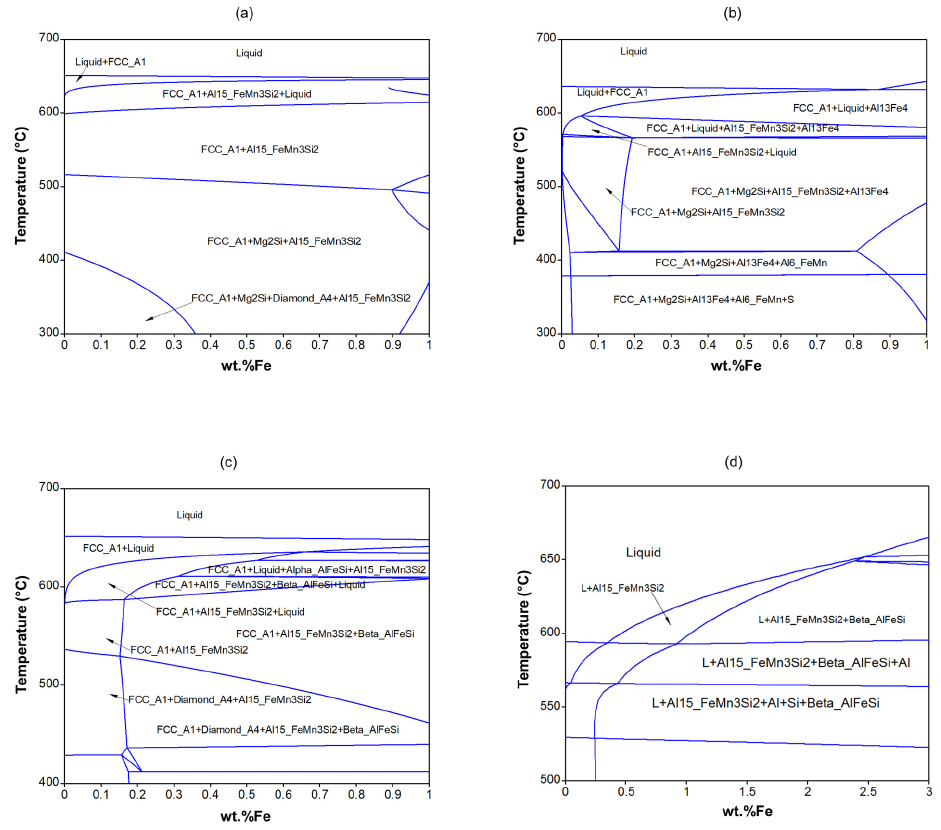
Figure 1. Equilibrium phase diagram versus Fe content for three wrought aluminium alloys and one aluminium cast alloy: ( a ) 6082-xFe; ( b ) 5182-xFe; ( c ) 6016-xFe and ( d ) A380-0.2Mn-xFe. Table 1. Minimum level to form P-Fe-IMCs and commercial composition limits for the different alloys shown in Figure 1. Alloy